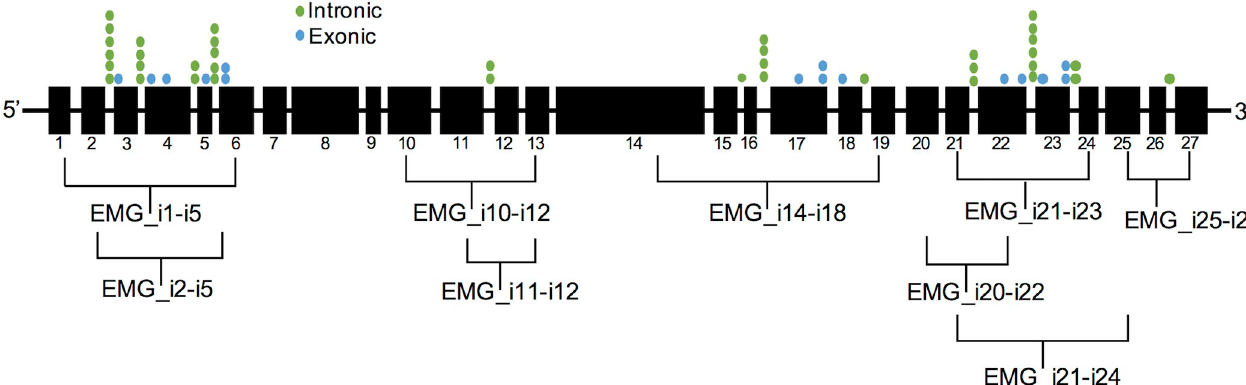
Fig 1. Graphical representation of CFTR gene and location of variants analyzed. Black boxes indicate exons and their size relative to other exons; lines between represent introns that are not to scale. Brackets indicate regions encompassed by expression minigenes (EMG, i: intron). Dots show location of variants studied (green: intronic, blue: exonic).